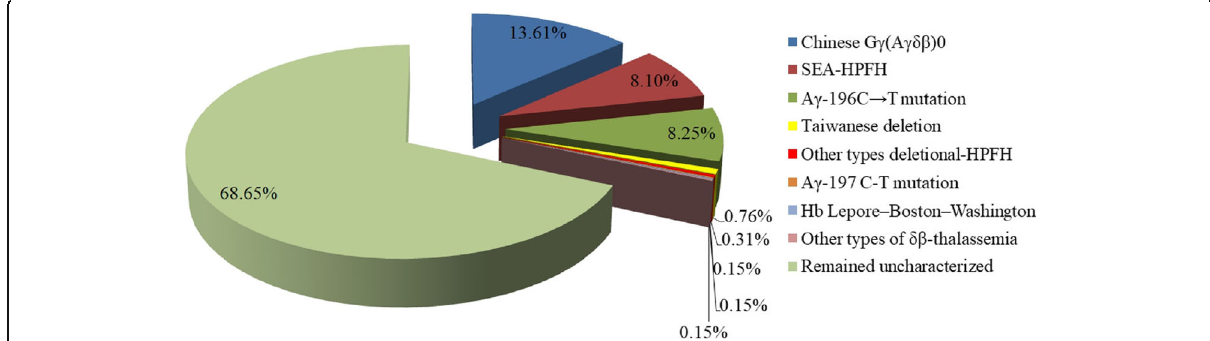
Fig. 1 Spectrum of δβ -thalassemia and Hereditary Persistence of Fetal Hemoglobin in 654 subjects with HbF>5%